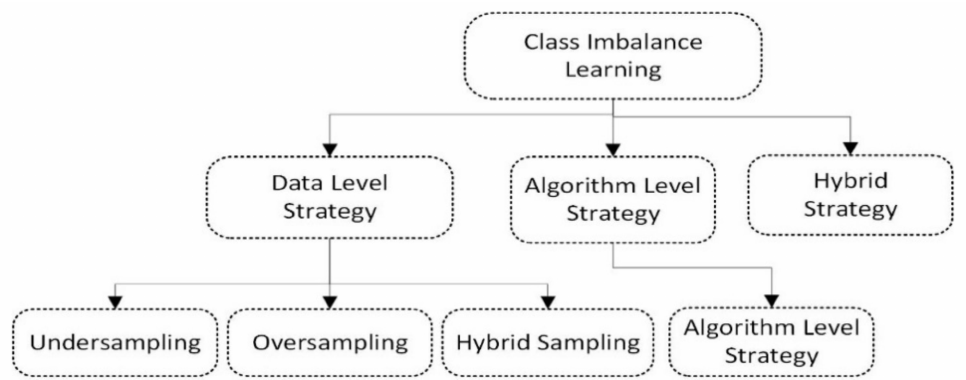
Figure 1. Categorization of class imbalance